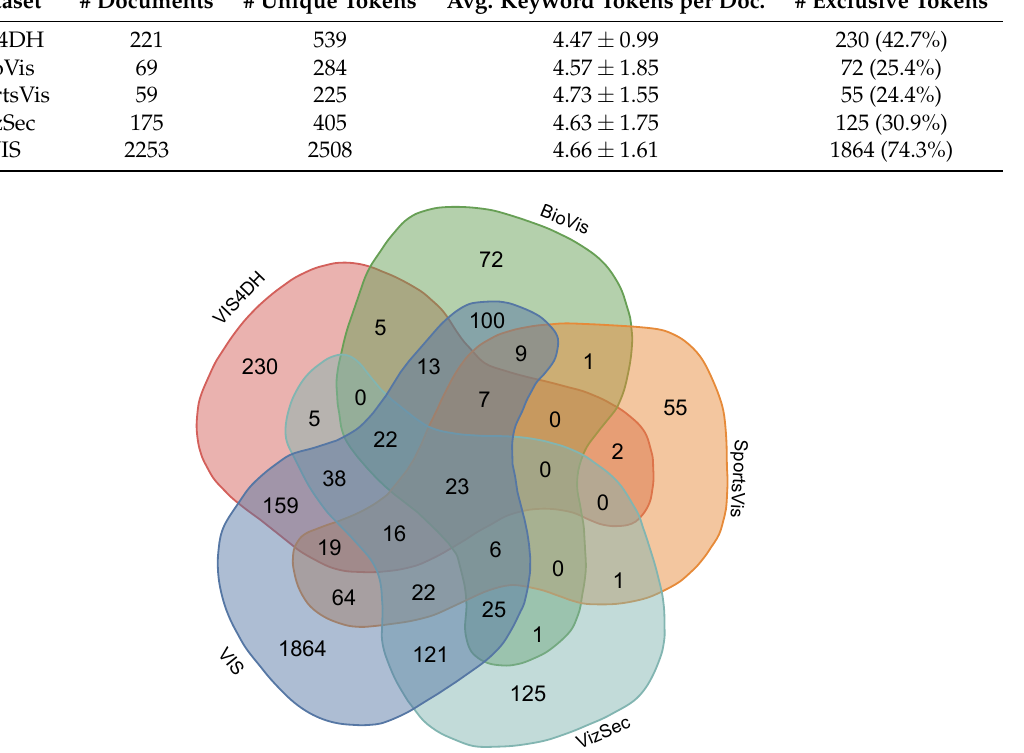
Figure 5. Venn Diagram (generated with the online tool at http://bioinformatics.psb.ugent.be/ webtools/Venn/) displaying intersections between the five datasets that were employed in our study. The specific keyword sets found on each intersection can be consulted in Table S1 of Supplemental